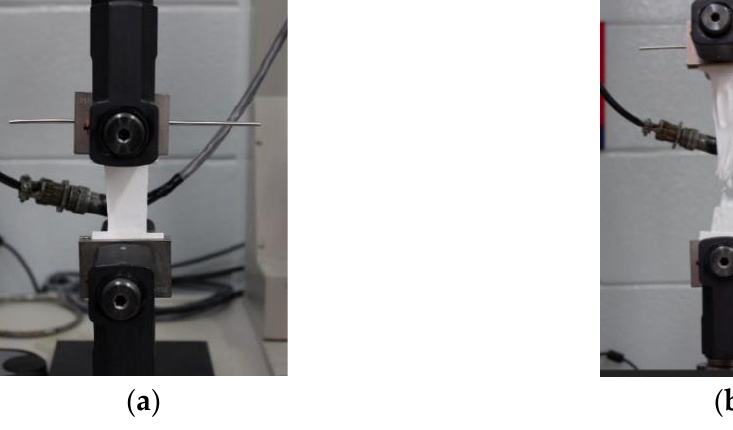
Figure 6. Electrospun membrane specimen ( a ) loaded onto the Sintech 2/G materials testing system for uniaxial tensile testing, and ( b ) tested till